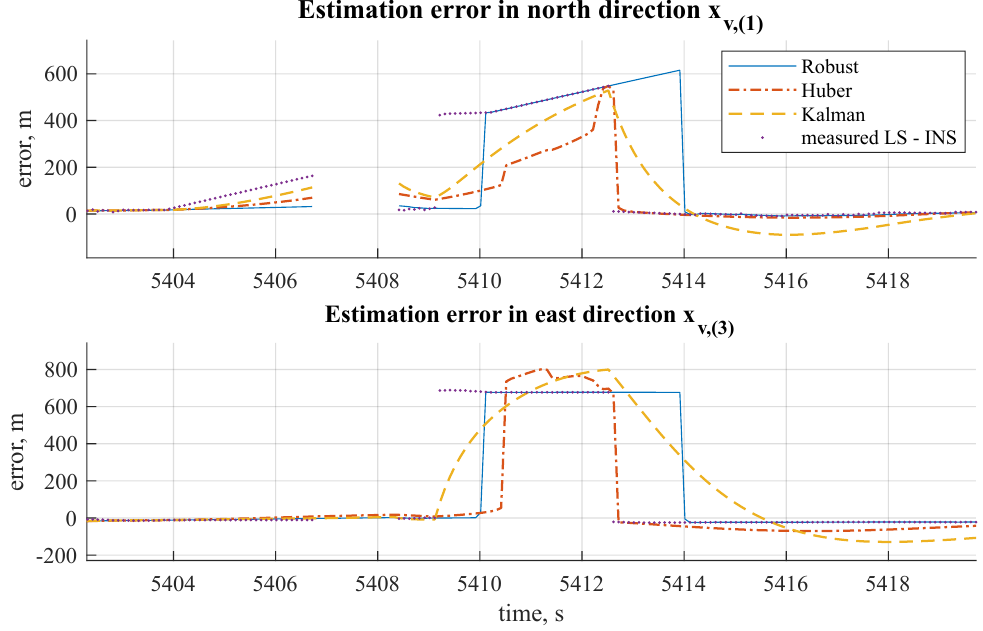
Figure 11. Filter response to abnormal U-shape error in landing system measurements. «Robust»—the proposed robust algorithm. «Huber»—M